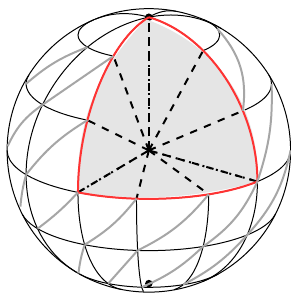
Figure 1 . A triangulation of a ball shaped region. All bulk edges are radial, going from the boundary to a central vertex. The Regge action for this triangulation can be understood as a boundary action for the radial edge